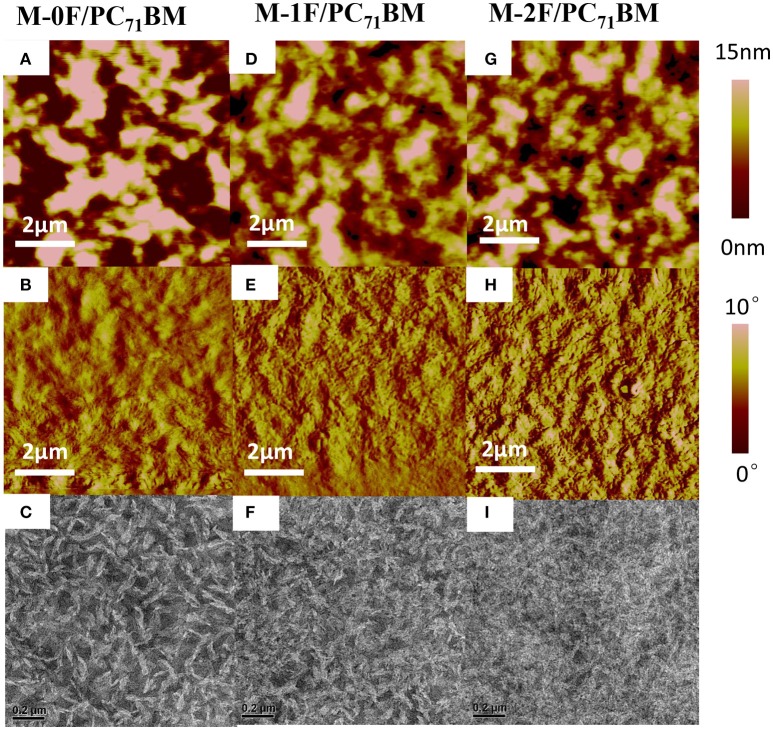
Tapping-mode AFM (A,D,G) topography and (B,E,H) phase images and (C,F,I) TEM images of (A–C) M-0F/PC71BM, (D–F) M-1F/PC71BM, (G–I) M-2F/PC71BM blend films.